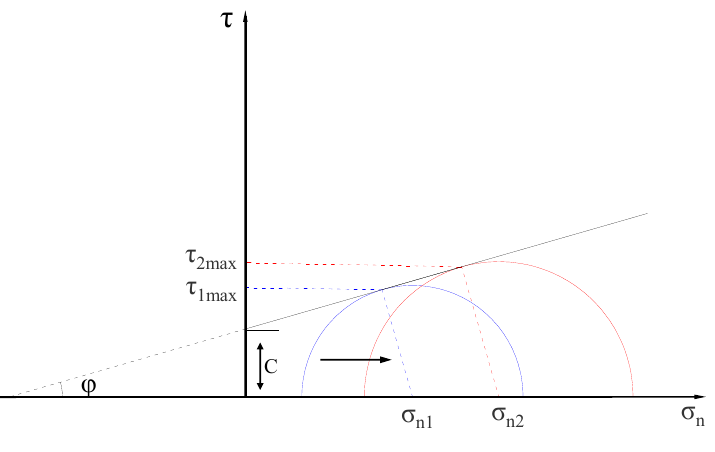
Figure 13. Mohr–Coulomb strength criterion.